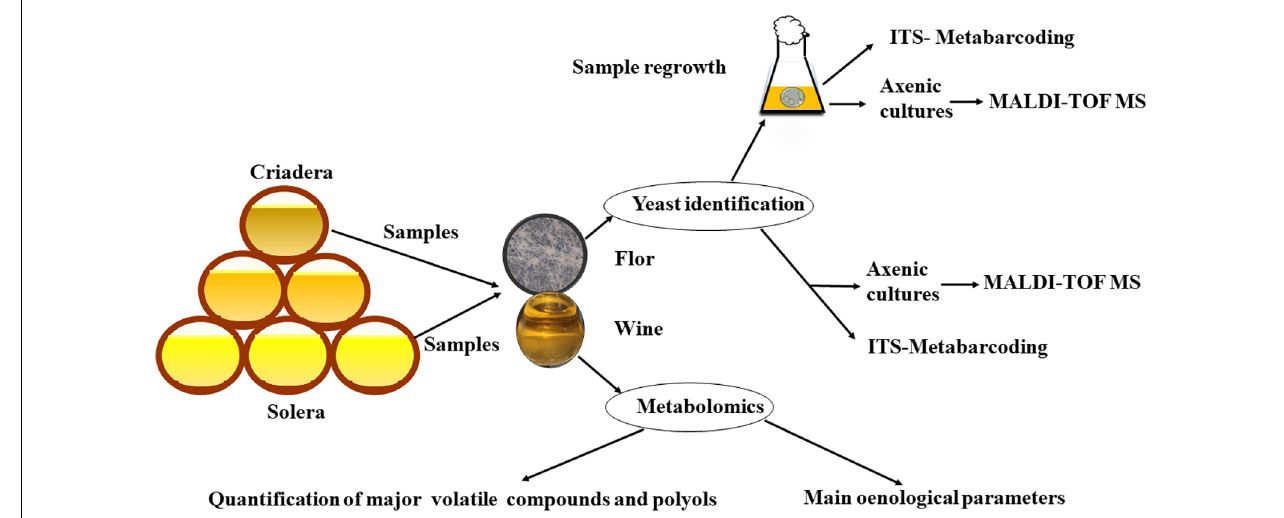
FIGURE 1 | Workflow of material and methods/experimental